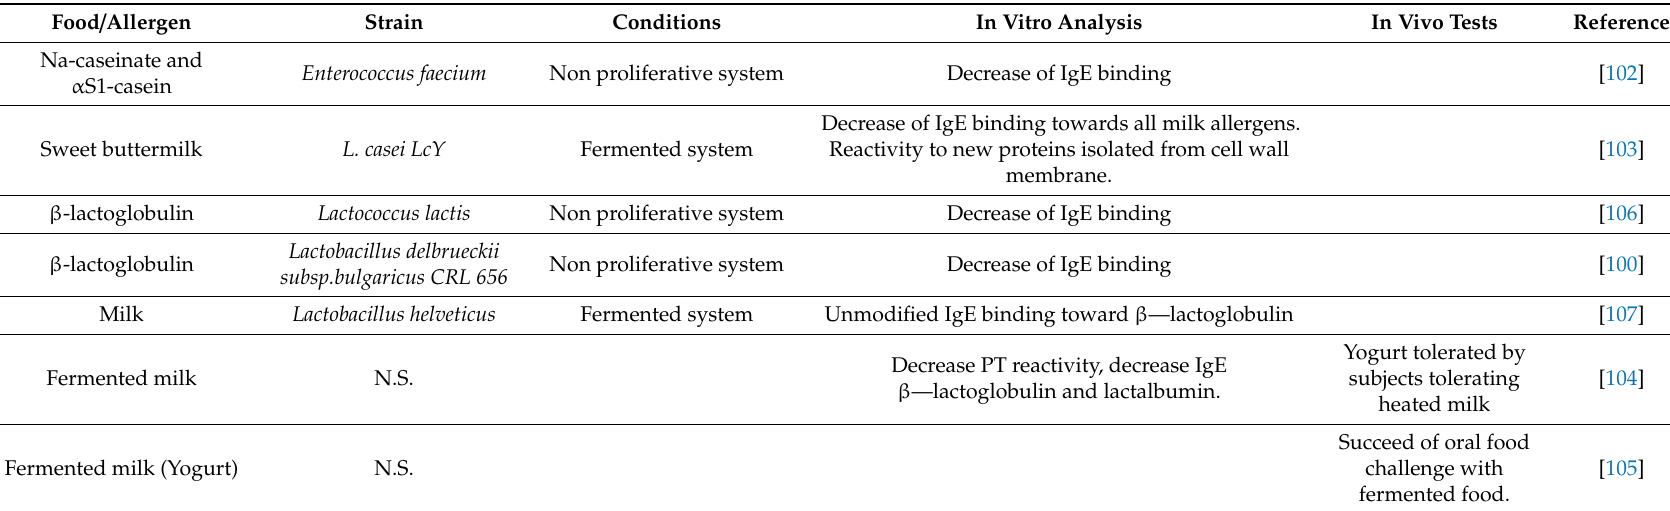
Table 3. Main studies on the e ff ect of fermentation of dairy products and its impact on their antigenicity and